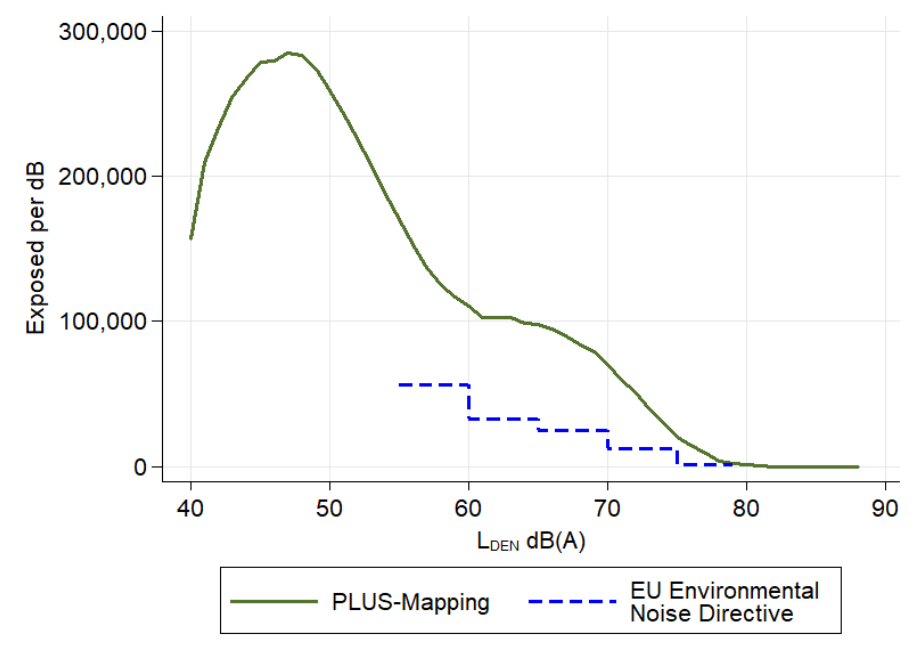
Figure 1. Number of road-traffic-noise-exposed residents (L DEN ) in Hesse, Germany based on 2017 “PLUS-Mapping” [22] or the EU Environmental Noise Directive mapping of Hesse, Germany. According to the “PLUS-Mapping” 619,571 residents were not exposed to road noise (L DEN ≤ 40 dB[A]). Using the EU Environmental Noise Directive mapping, 5,474,104 residents were not exposed to road noise (L DEN < 55 dB[A]).